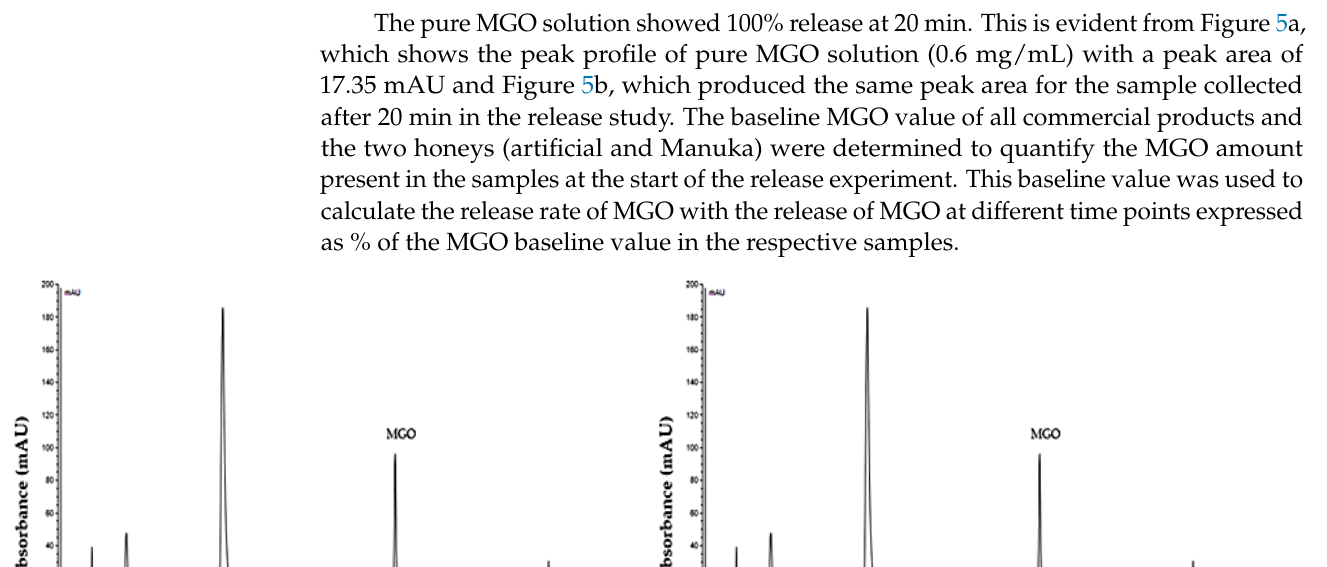
Figure 4. Peak profile of MGO released from the commercial ‘Product E’ at different time points: ( a ) 15 min, ( b ) 30 min, ( c ) 1 h, ( d ) 3 h, ( e ) 6 h, ( f ) 9 h, ( g ) 12 h and ( h ) Baseline.